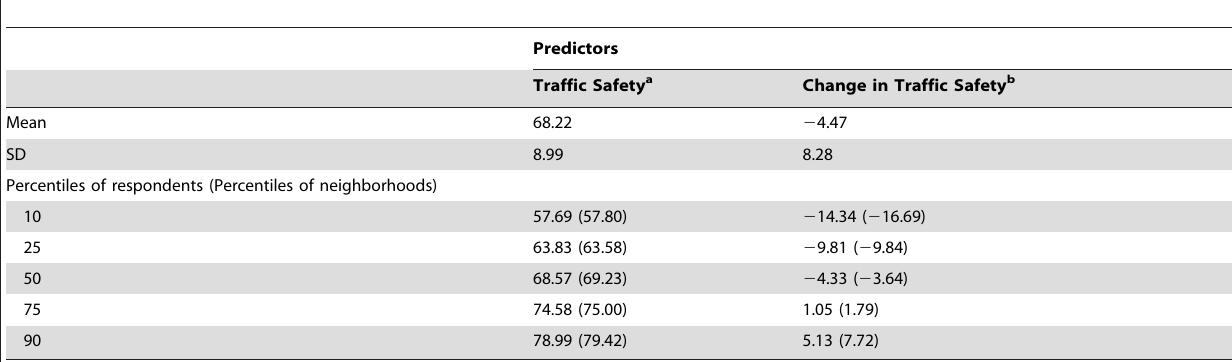
Table 2. Mean, standard deviations (SD), and percentile distribution for traffic safety in 2006 and change in traffic safety between 2006 and 2009, for 2009 respondents.